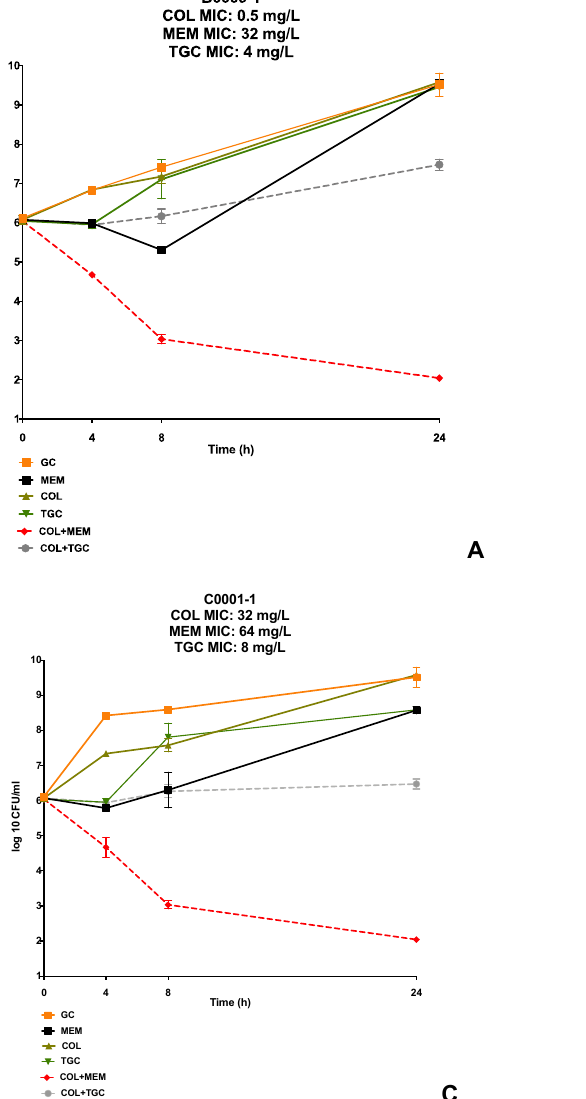
Figure 1. Three representative TKAs, with varying COL-susceptibility ( A – C ). GC represents the growth control of each organism tested in each respective TKA. The following concentrations of the antibiotic were utilized in the time-kill experiments: COL was tested at 0.5 × the MIC (0.25 mg/L) in B0009-1, and at the biological free peak concertation (2 mg/L) in B0017-1, and C001-1. MEM and TGC were tested at their biological free peak concentrations (30 mg/L and 1.5 mg/L, respectively) against all isolates. The error bars are representative of the standard deviations of the mean, as each TKA was completed in